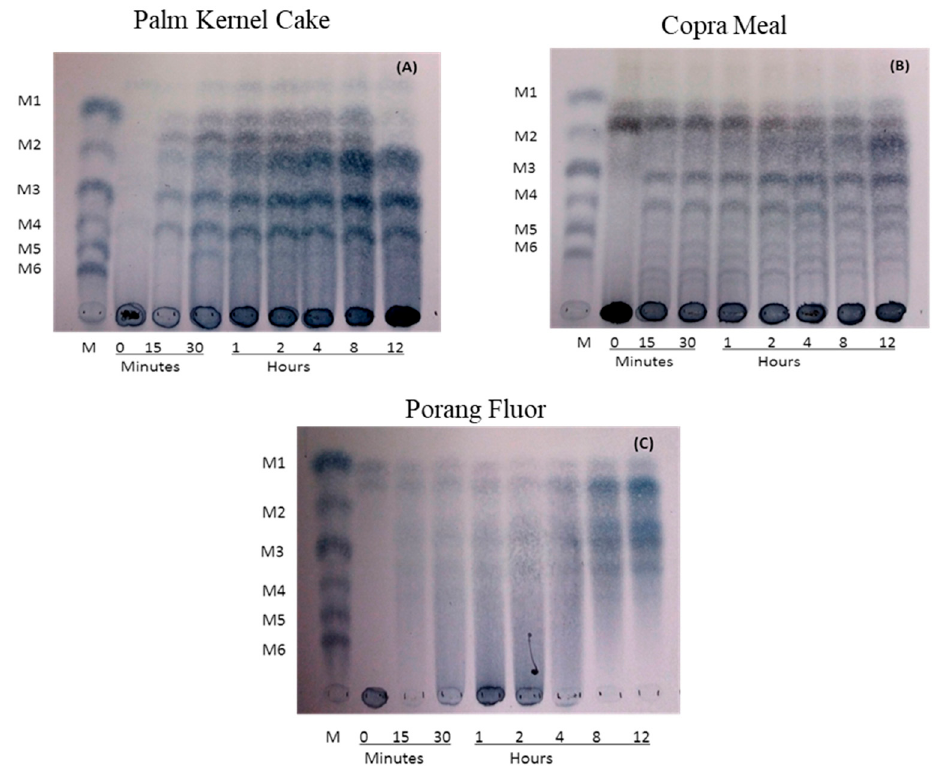
Figure 7. Thin-layer chromatography (TLC) of the hydrolytic products generated by purified ManNj6-379 on biomass powder: ( a ) palm kernel cake, ( b ) copra meal, and ( c ) porang flour. The reactions in the substrates in 50 mM sodium phosphate buffer (pH 6.0) with 1 μ g/ μ L of ManNj6-379 were incubated at 50 °C for 24 h. Six microliters of hydrolysate were spotted on the TLC plate. The incubation time is shown in min and h. The standard was a mixture of mannose and manno-oligosaccharides where M1 is mannose; M2, mannobiose; M3, mannotriose; M4, mannotetraose; M5, mannopentaose; and M6, mannohexaose.